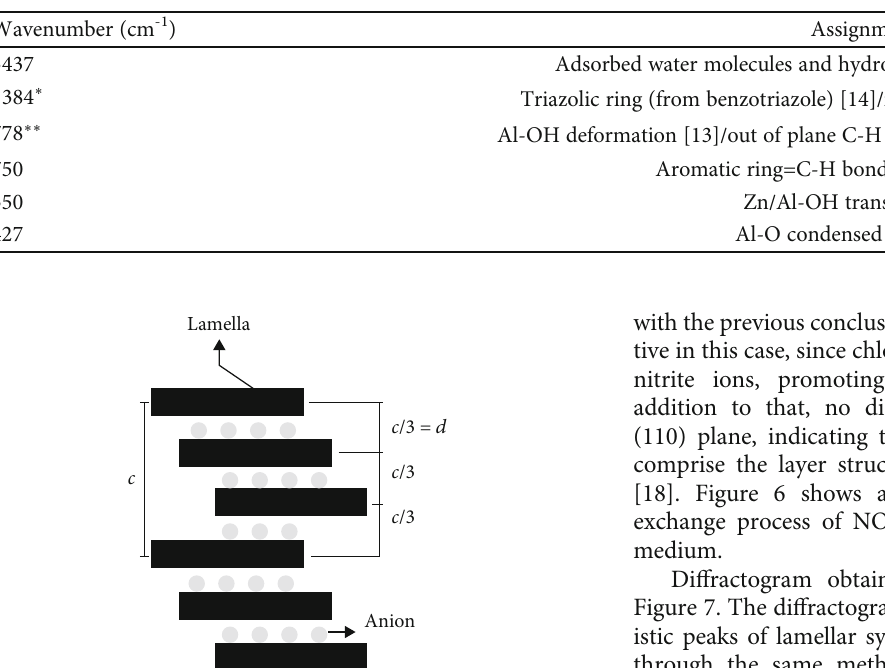
Table 2: Characteristic bands of FTIR spectrum obtained for BTZ-LDH.